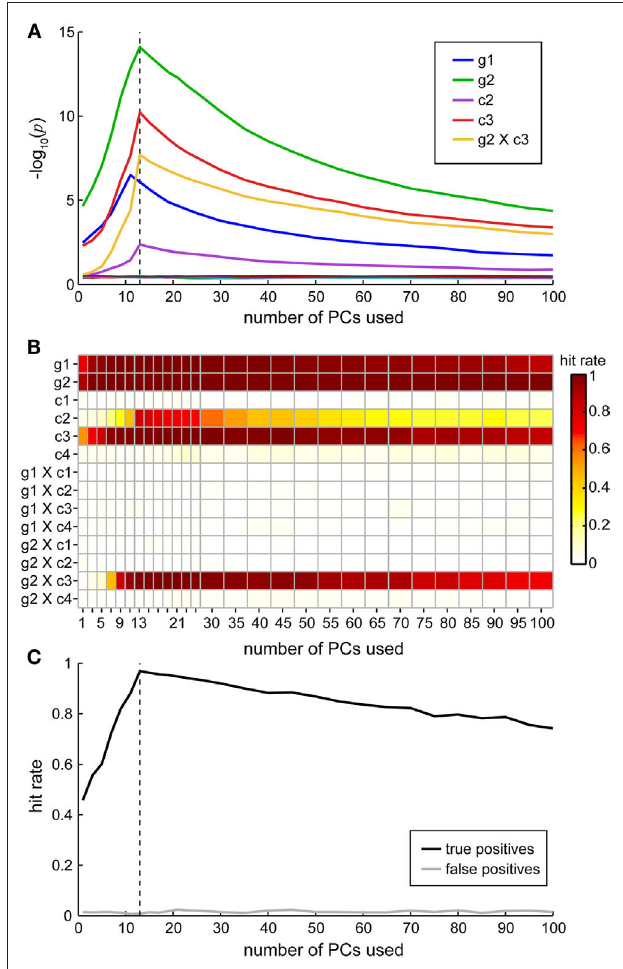
Figure A3 | Simulations showing benefits of dimension reduction using the MDL estimate. (A) Average p -values from the MANCOVA F -test for each model term over different number of components used, ranging from 1 to 100. Dashed black line shows the true number of dimensions estimated correctly as 13 by MDL for all 100 simulations. (B) Hit rate (fraction of times each model term appeared in the reduced model, following backward selection) as a function of components used. (C) True positives (average hit rate for true effects) and false positives (average hit rate for false effects) as a function of components used. Though difficult to see given the scale, the false positive rate was lowest at 11 and 13 components (0.0067 and 0.0078, respectively), and never rose above 0.024 (21